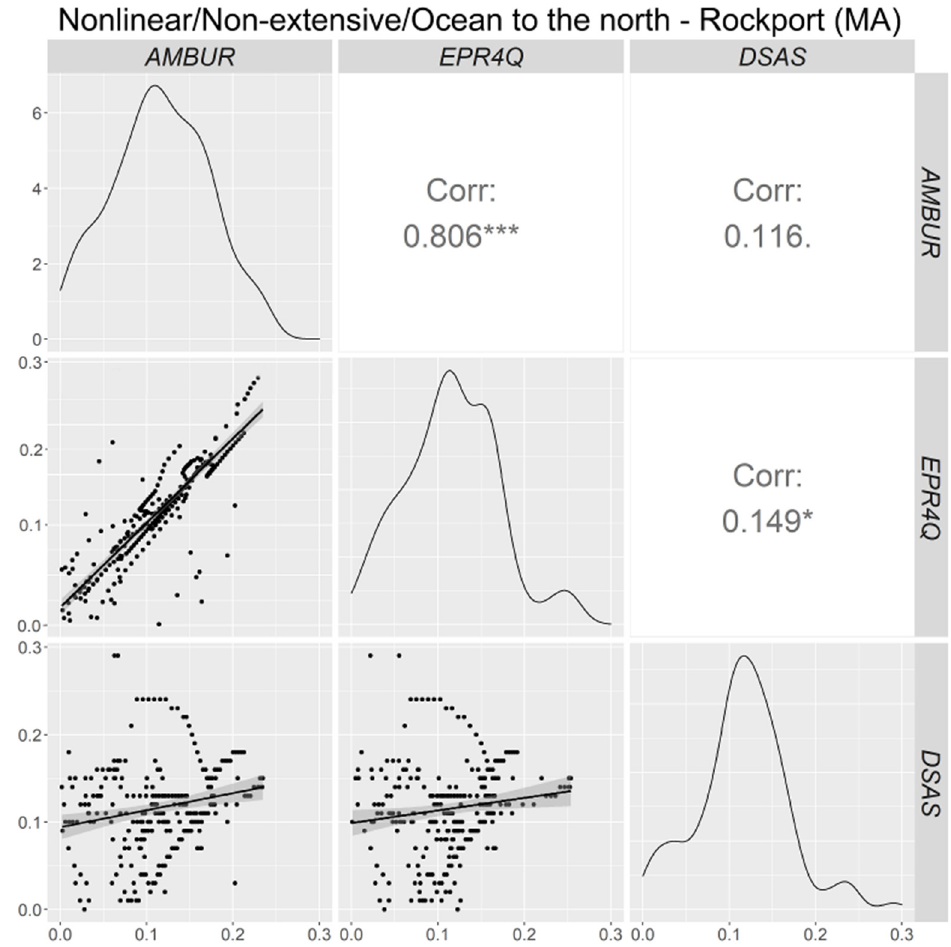
Figure 12. Matrix correlation of AMBUR, EPR4Q, and DSAS models on on Nonlinear/Non-extensive/Ocean to the north for Rockport coast. p-value significance symbols: “***”—0.001; “**”—0.01; “*”—0.05; “.”—0.1; No symbol—1. The matrix correlation shows the scatter plot between the models (EPR4Q × DSAS, EPR4Q × AMBUR, AMBUR × DSAS) on the left side. The frequency curve of the histogram of each model on diagonal and Pearson’s correlation is presented on the right.